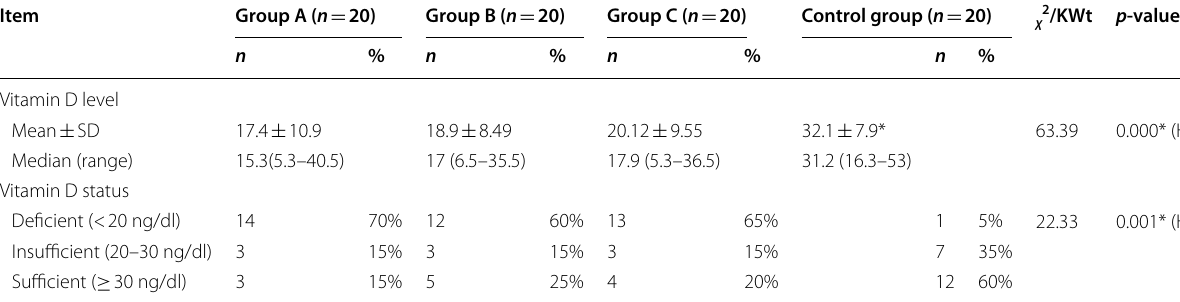
Table 4 Vitamin D level among the studied groups